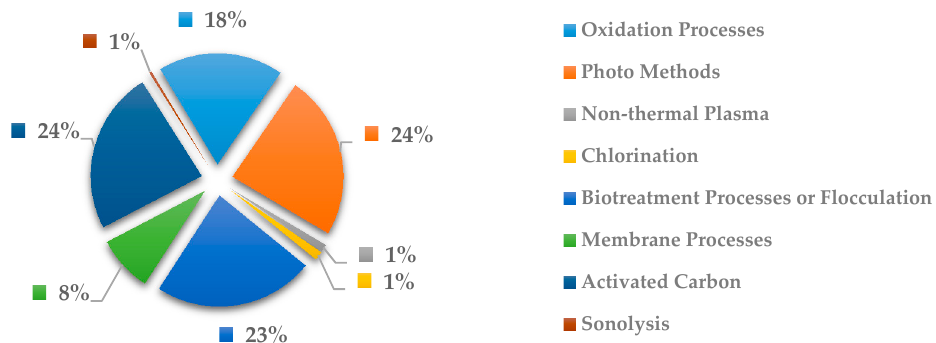
Figure 24. Percentage of scientific articles worldwide regarding wastewater treatments of anti-infective drugs between 1998 and 2020. Data collected in Scopus database by using wastewater or water as keywords and English as a language limitation.